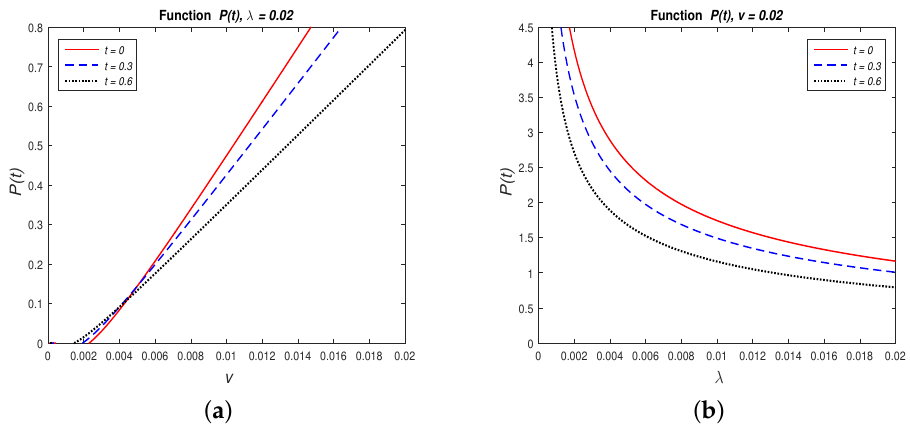
Figure 4. Time evolution of European put option price P ( t ) and dependent on v ( a ) and λ ( b ).